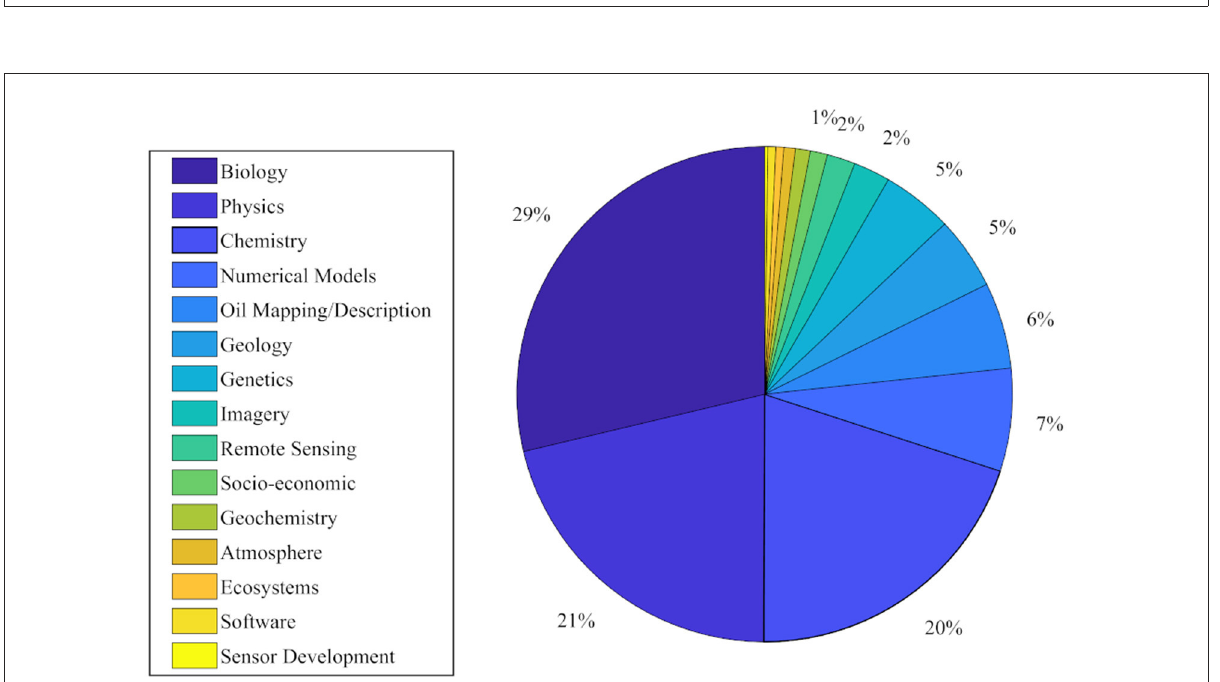
FIGURE1 GRIIDC timeline of events.